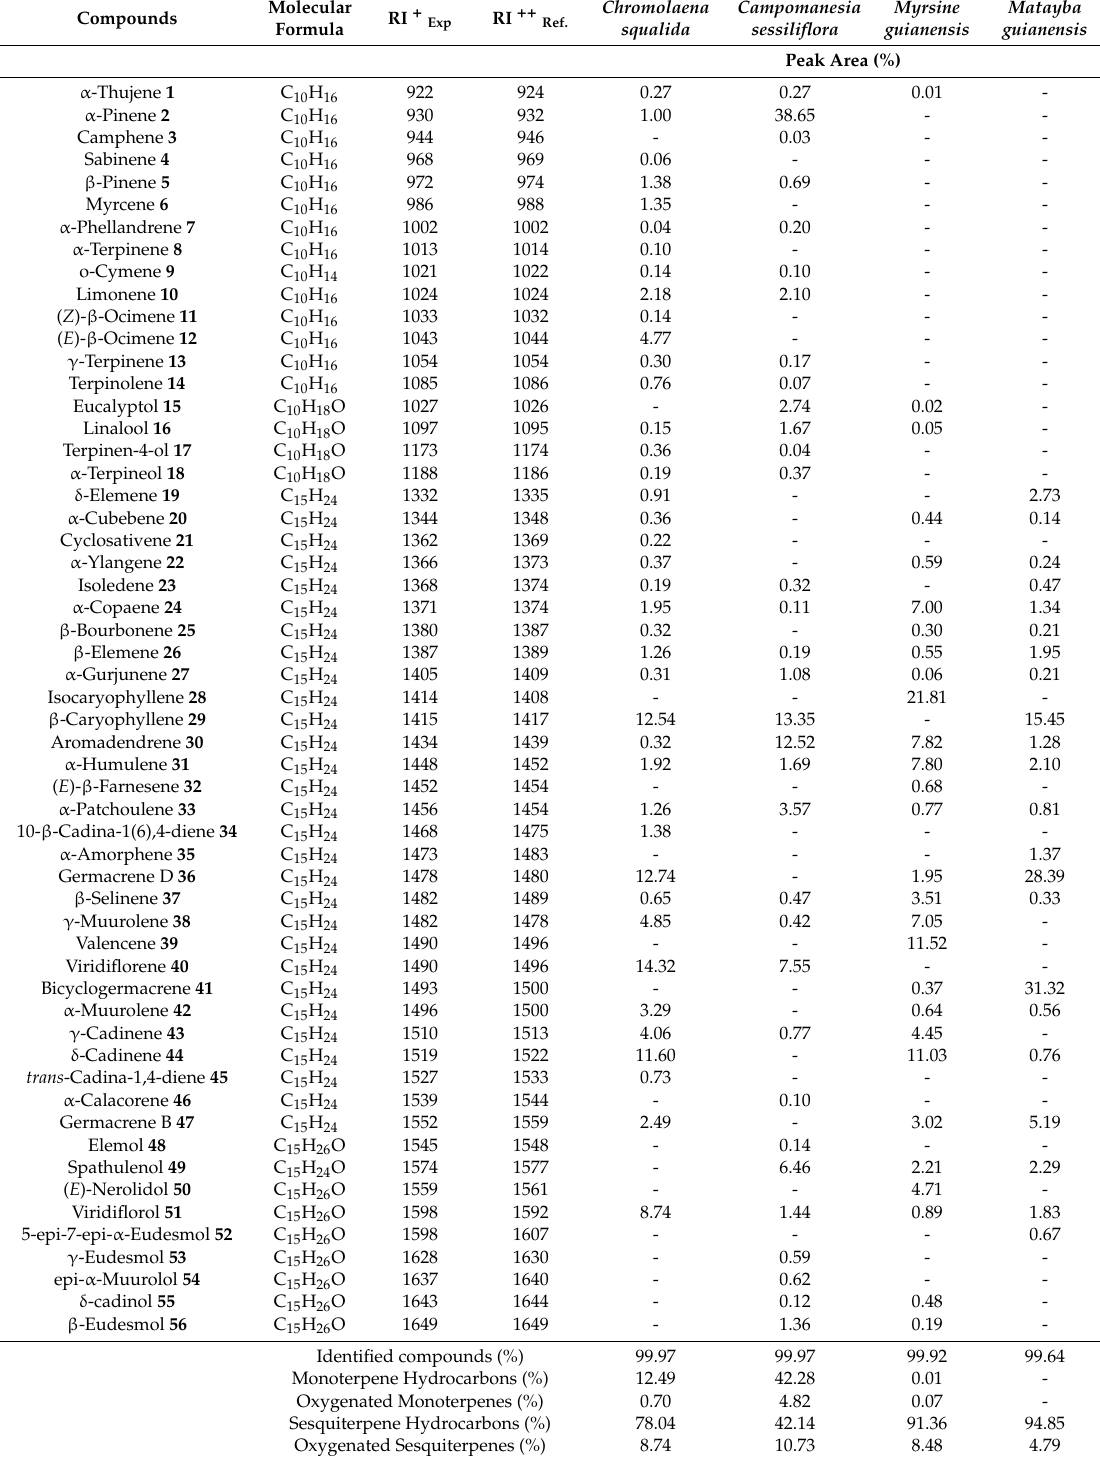
Table 2. Chemical composition of the bioactive essential oils from Cerrado species. Molecular Compounds